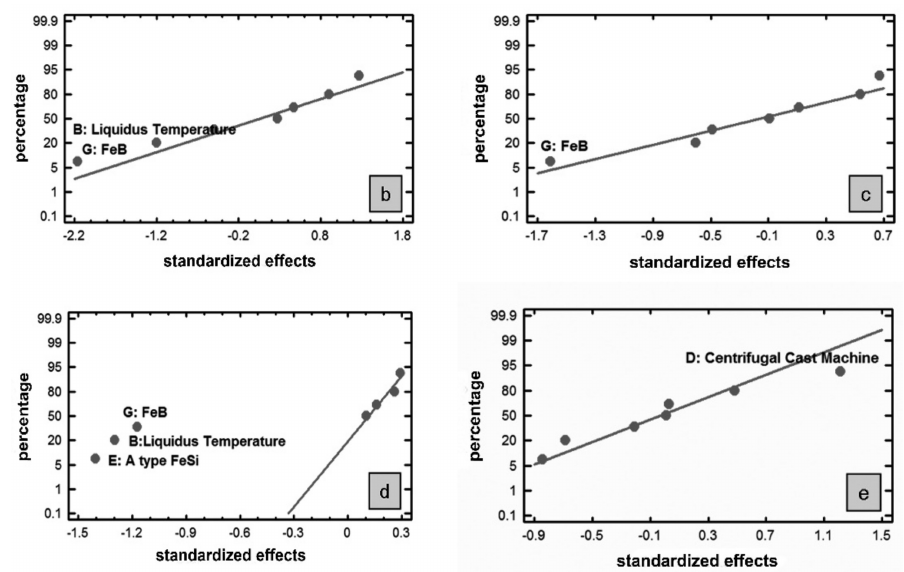
Figure 2. ( a – e ) Normal Probability Plot for the Volume Fraction of Graphite (%) in: ( a ) the Layer Average; ( b ) the periphery of the layer (zone I); ( c ) zone II; ( d ) zone III; and ( e ) in the layer section adjacent to the shell- interface region (zone IV).